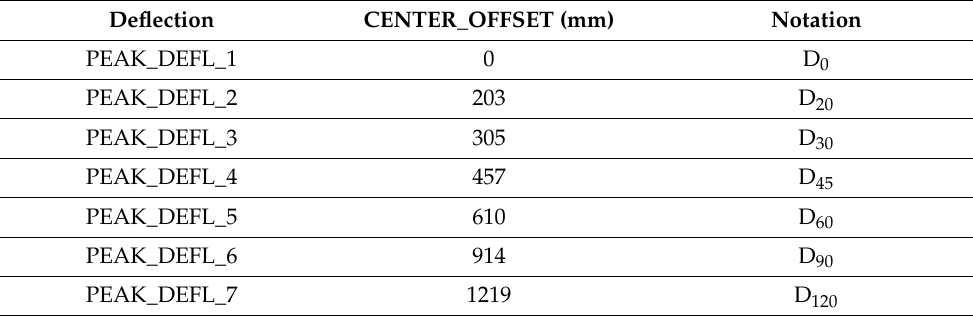
Table 1. Center offsets of seven deflection